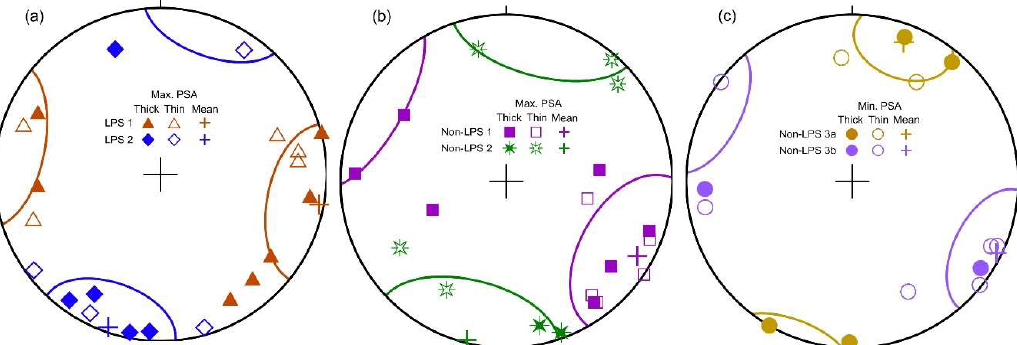
Figure 10. Lower-hemisphere, equal-area projection of the maximum principal stress axes of each compression subset (a–b) and the minimum principal stress axes of the extension subset (c). For each subset, the mean direction and angular dispersion of these axes are displayed as a plus symbol and a small circle centered at it.